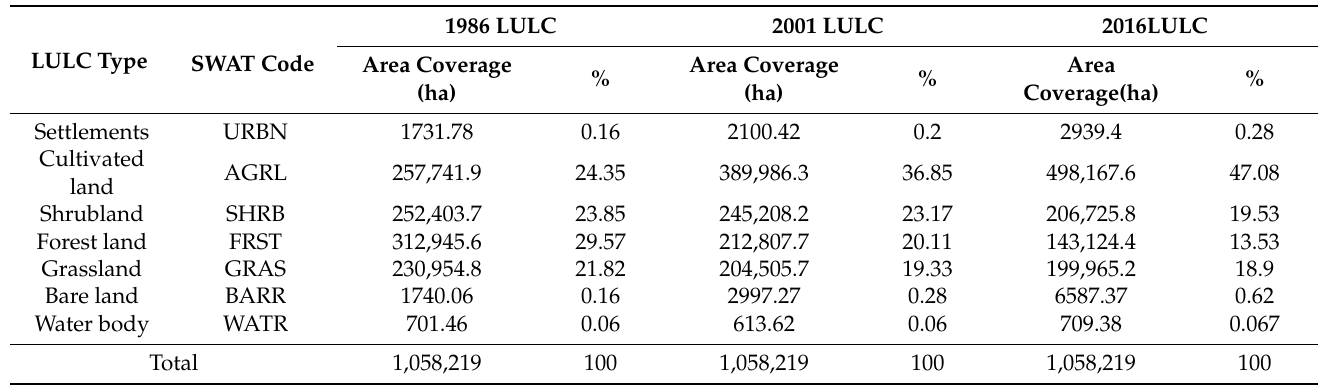
Table 2. LULC in the years 1986, 2001, and 2016.